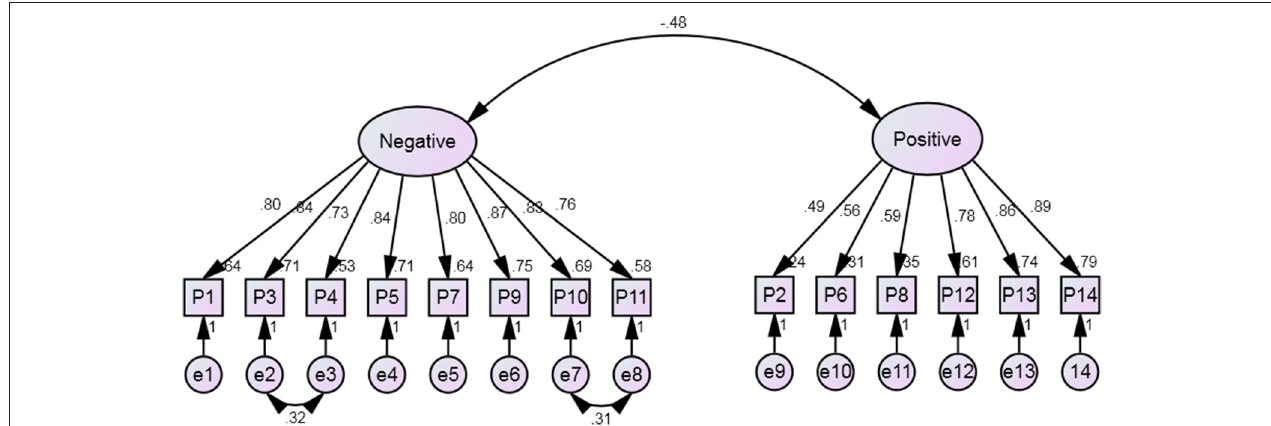
FIGURE 1 | Two factor PANSI measurement modelconstruct.